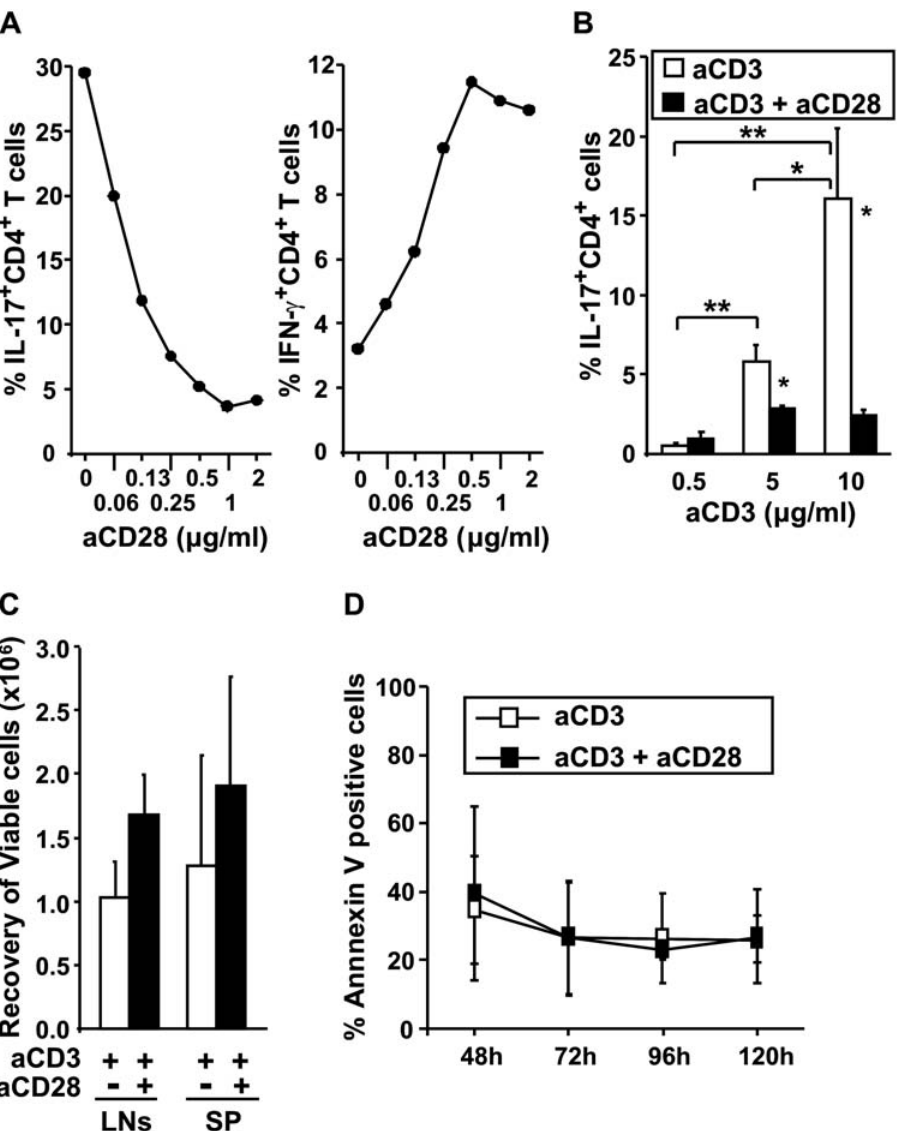
Figure 3. TCR avidity and CD28 co-stimulation signals regulate Th17 development. (A) Purified CD4 + T were stimulated with plate-bound anti-CD3 (5 m g/ml) and titrated doses of soluble anti-CD28 mAb under Th17 polarizing conditions. Cells were stained intracellularly for IL-17 and IFN- c expression. The data shown is one representative experiment out of two. (B) CD4 + T cells were stimulated with titrated doses of plate-bound anti-CD3 in the presence or absence of soluble anti-CD28 mAb (2 m g/ml). Data represent the mean 6 SD of four independent experiments. (C) Cumulative data of viable CD4 + T cell recovery after stimulation with anti-CD3 (5 m g/ml) the presence or absence of anti-CD28 mAb (2 m g/ml). Data are the mean 6 SD of 3 (LNs) to 20 (spleen) independent experiments. (D) CD4 + T cells were stimulated with coated anti-CD3 (10 m g/ml) in the presence or absence of soluble anti-CD28 under Th17 conditions and analyzed at different time points for the percentage of apoptotic cells (Annexin V binding positivity). Mean values 6 SD obtained from at least three separate experiments are presented. P values were calculated using the two-tailed, paired Student’s t test, *, P , 0.05; **, P , 0.01.